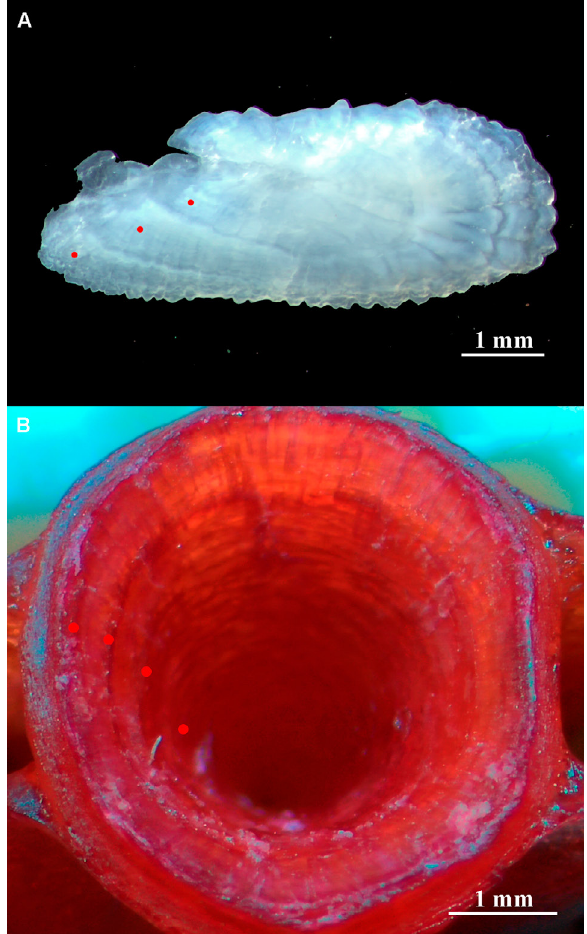
Fig. 2. – Graphical interpretation of annual growth increments in otoliths (A) and the vertebral centrum (B). A, shows an otolith of an individual of Trachinotus ovatus with a length of 24 cm L ; F the otolith has three complete opaque rings, and another one is incomplete at the otolith edge. B, shows a vertebral centrum of an individual of T. ovatus with a length of 23.5 cm L and an age of F four